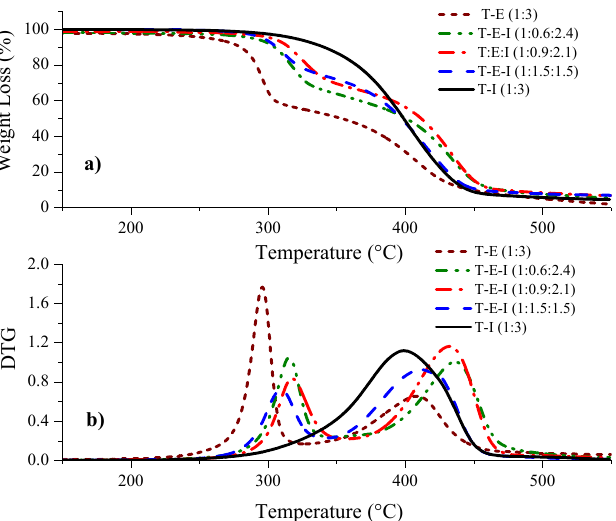
Figure 6. Results of TGA analysis of polyHIPEs: ( a ) weight loss vs. temperature, ( b ) derivative curves versus